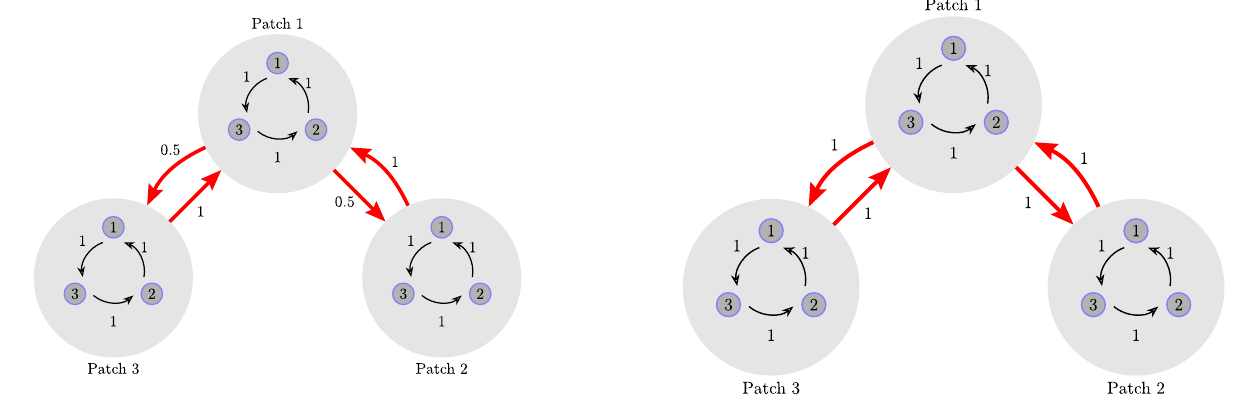
Figure 2. Left: A heterogeneous dispersal graph according to 35 . Right: A homogeneous dispersal graph according to our